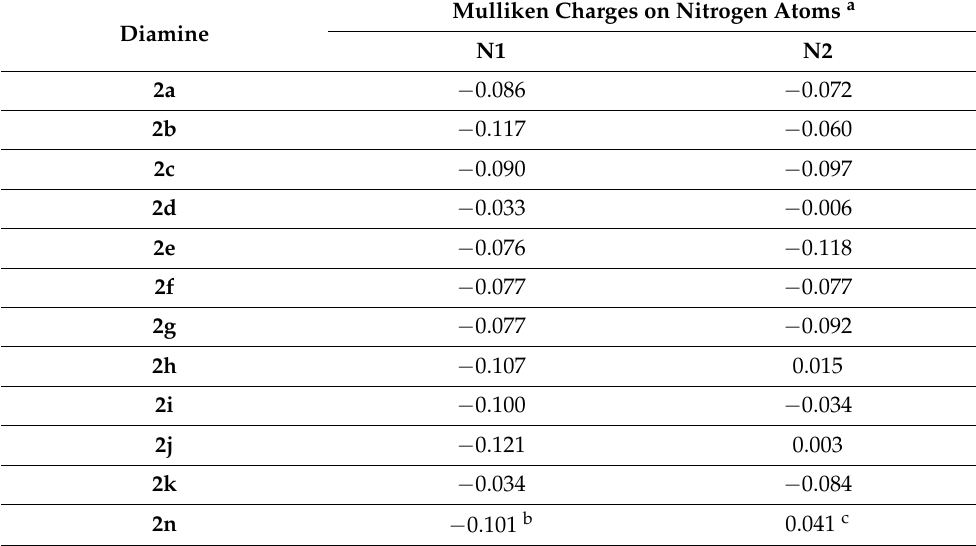
Table 2. Mulliken charges on nitrogen atoms of 2a–k , 2n